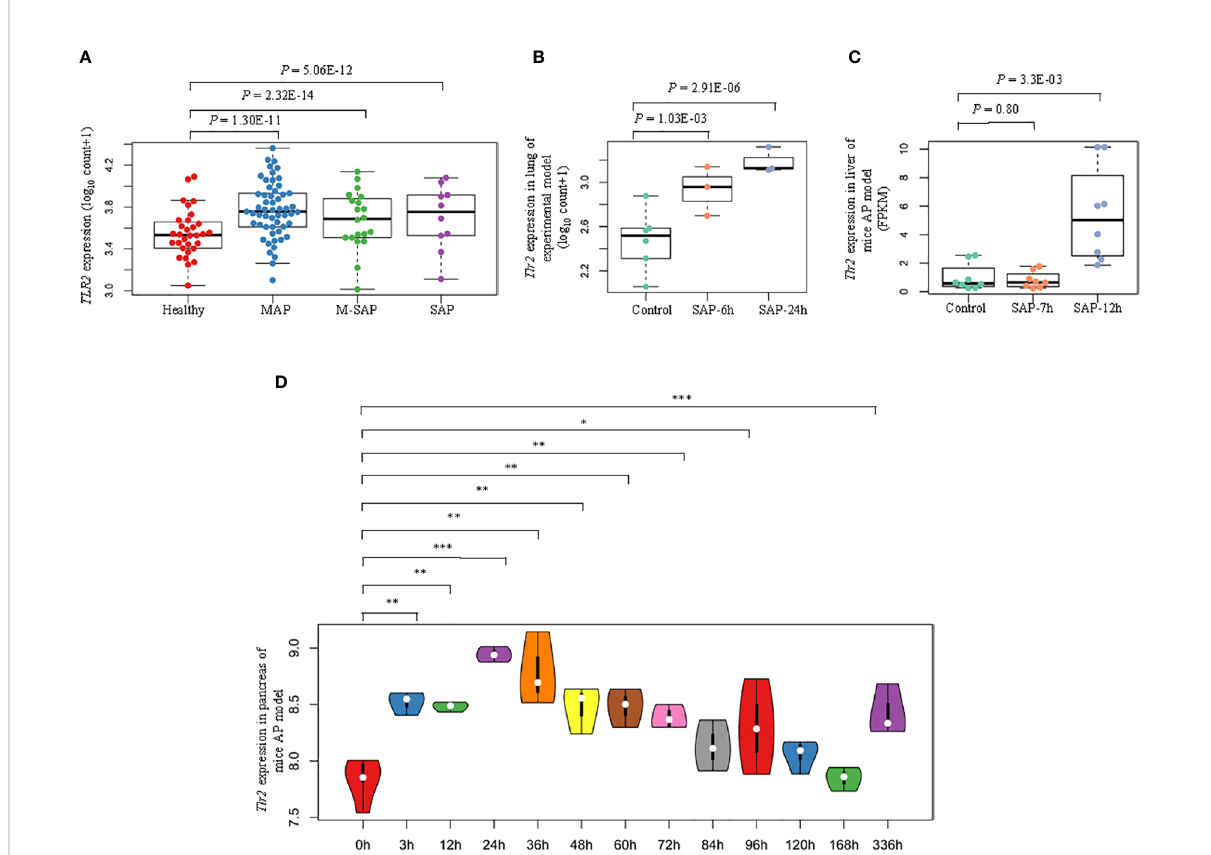
FIGURE 5 Schematic diagram of identi fi ed epigenetic aberrations of TLR2 in AP. (A) Box plots indicate the differential expression patterns of TLR2 between each severity level of AP (MAP, M-SAP, SAP) and normal controls in human peripheral blood. (B) Box plots represent the differential expression pro fi les of Tlr2 at 6 hours and 24 hours after lung injury and (C) at 7 hours and 12 hours after liver injury in the cerulein-induced AP mouse model. (D) Violin plot indicating dynamic fl uctuations in Tlr2 expression at thirteen consecutive time points in pancreatic tissue from the AP mouse model: *P < 0.05; **P < 0.01; ***P <